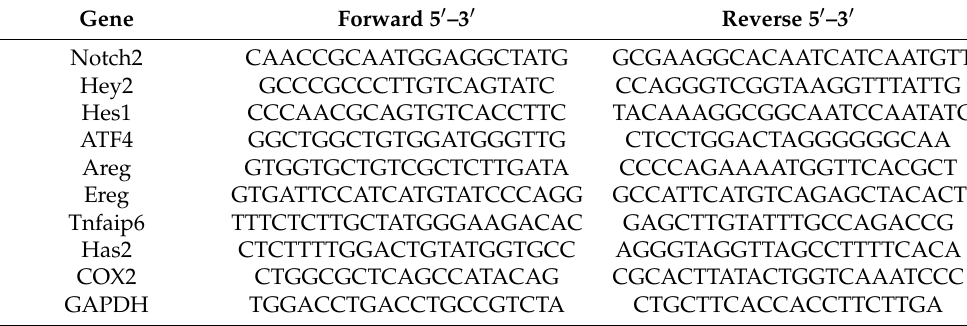
Table 2. List of primers used for real-time